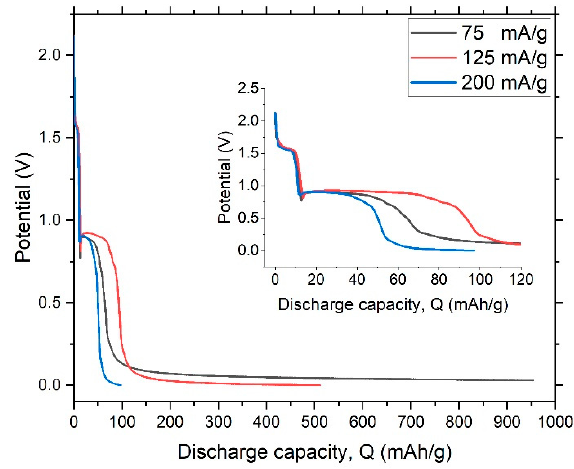
Figure 12. Discharge-potential curve of the dealloyed glassy alloy ribbon sample at different constant currents.